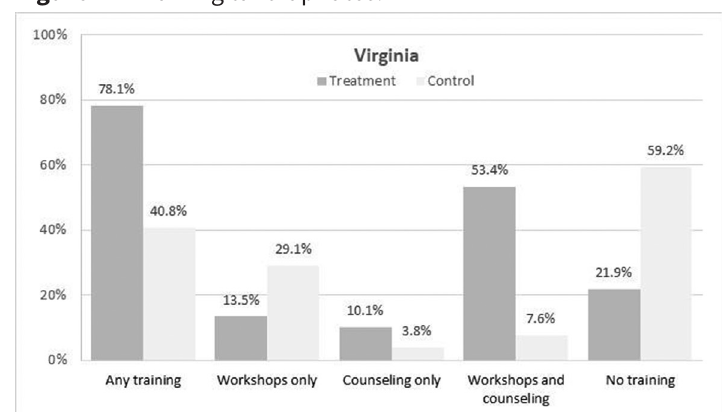
Figure 1 Training take-up rates.